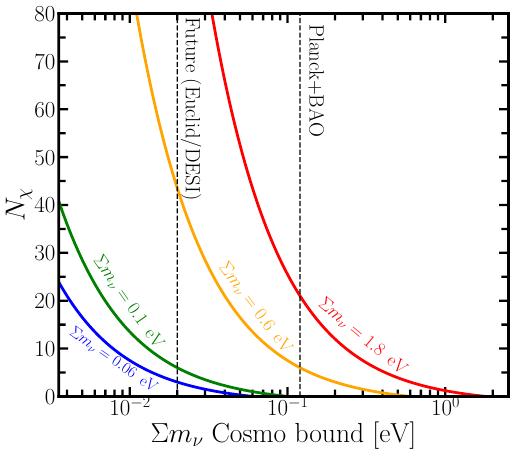
Figure 1 . Number of massless fermions χ with g χ = 4 degrees of freedom needed to make the standard cosmological bound (shown on the horizontal axis) consistent with different values of the sum of the neutrino masses P m . The vertical dashed lines indicate the current cosmological bound ν from Planck+BAO data, eq. (1.1), and the prospect for future cosmological observations (0.02